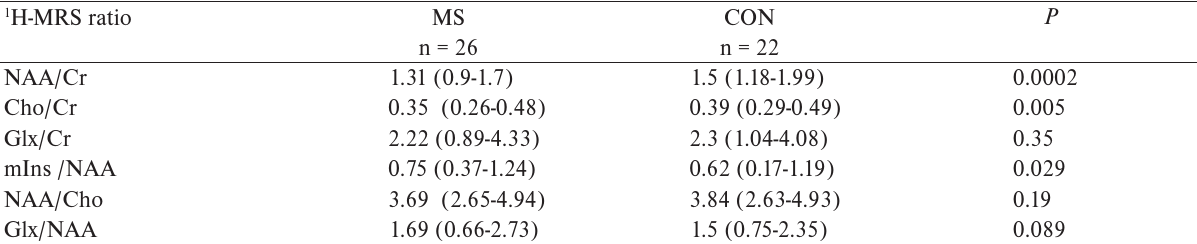
Table 2. Summary of 1 H-MRS metabolite ratios in MS patients and healthy